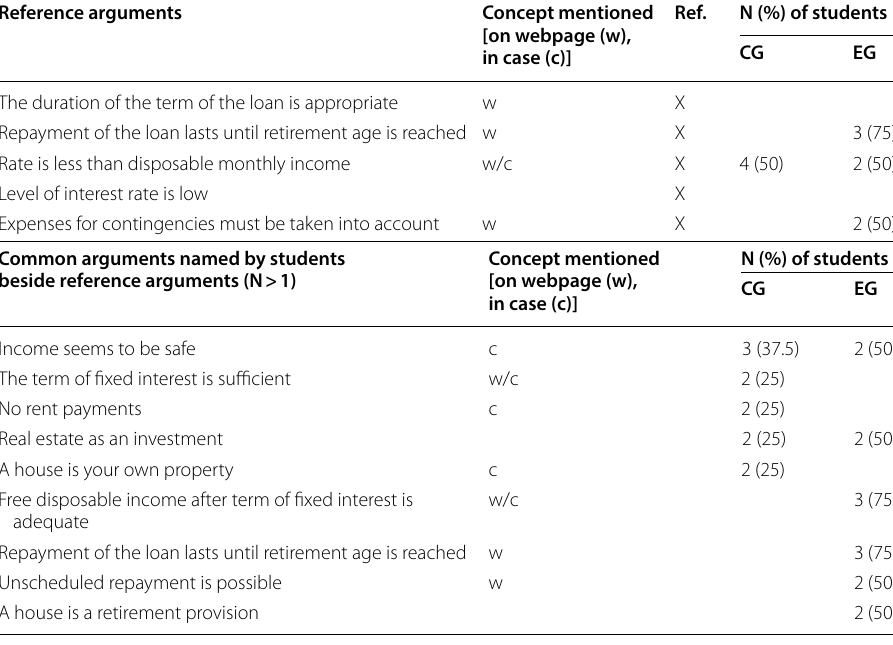
Table 8 Arguments for taking a mortgage loan (decision